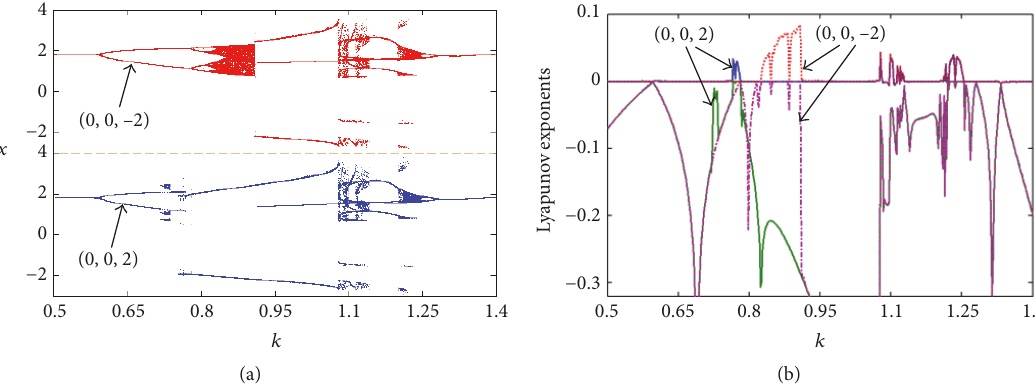
Figure 4: For the initial values (0, 0, − 2) and (0, 0, 2), hidden coexisting asymmetric behaviors with 𝐼 = 1 and 𝑘 = 0.5 ∼ 1.4. (a) Bifurcation diagrams of 𝑥 . (b) First two Lyapunov